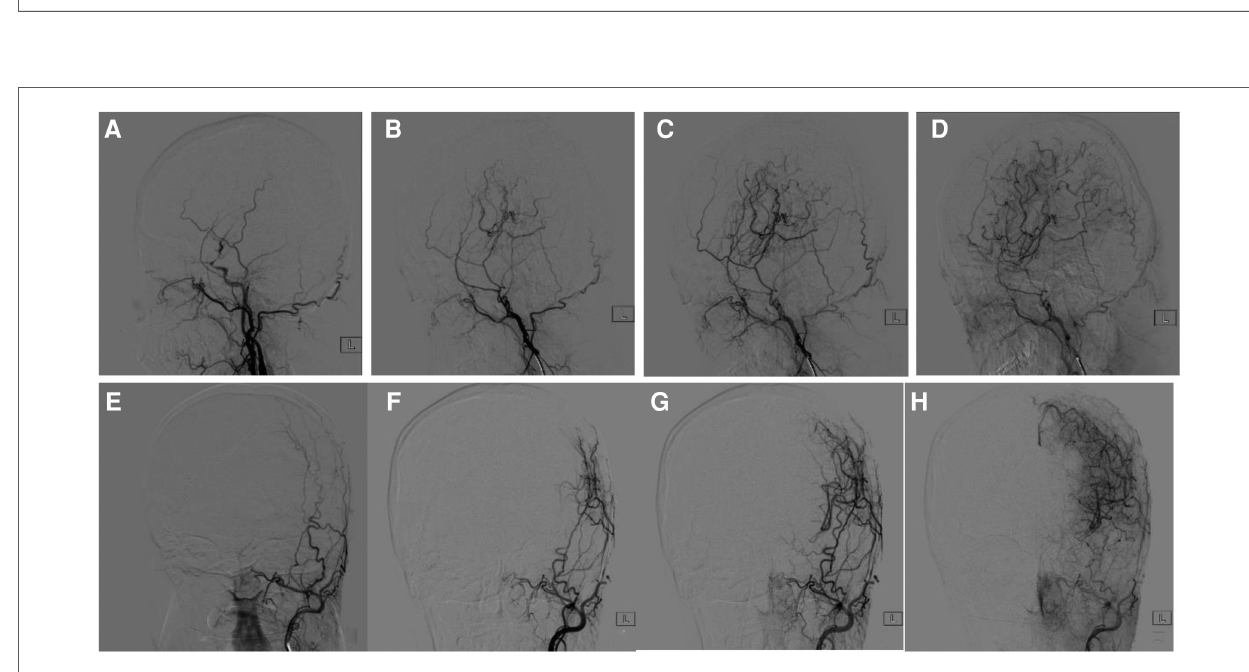
FIGURE 4 Comparison of cranial DSA before and 6 months after surgery. ( A ) 47-year-old woman with moyamoya disease accepted surgery. ( A ) Lateral view of external carotid artery before surgery. ( B – D ) 6-months follow-up. ( E ) Anteroposterior view of external carotid artery before surgery, ( F – H ) 6-months follow-up. Postoperative DSA showed the establishment of collateral circulation and obvious capillary neogenesis, which were connected with the intracranial.